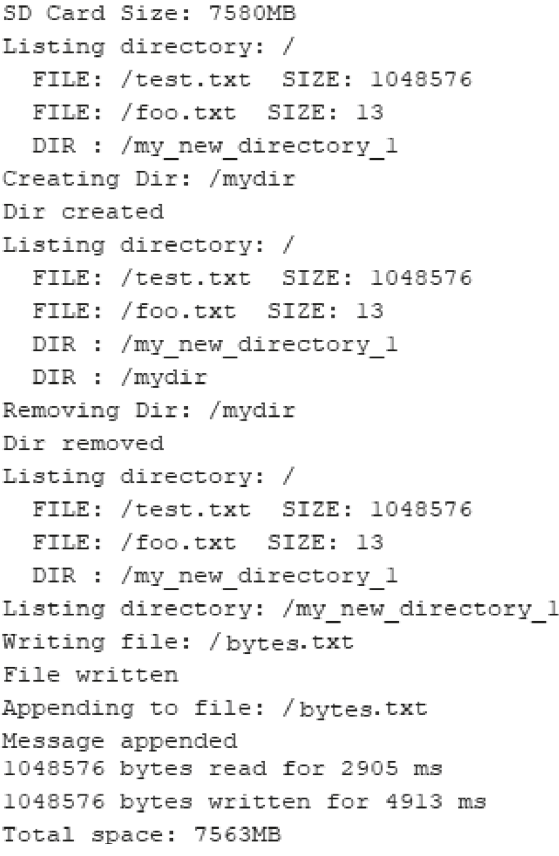
Figure 5: Configuring SD card for data